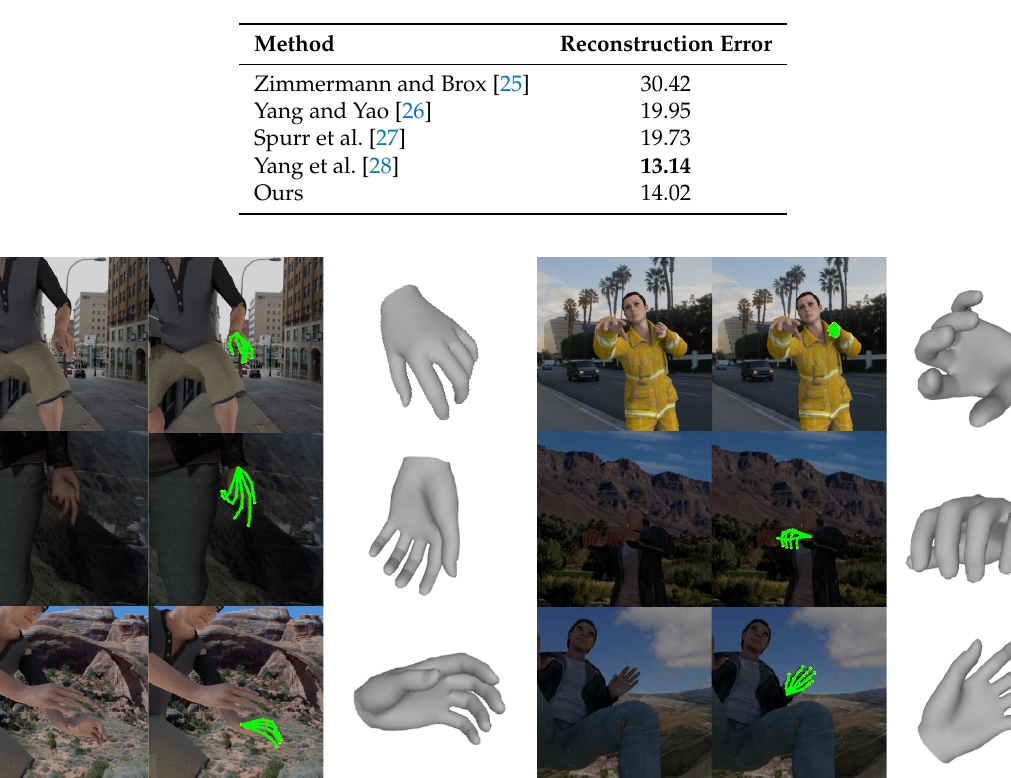
Table 7. Quantitative comparison with existing methods on the Rendered Handpose Dataset (RHD) dataset. The numbers denote reconstruction errors in mm.